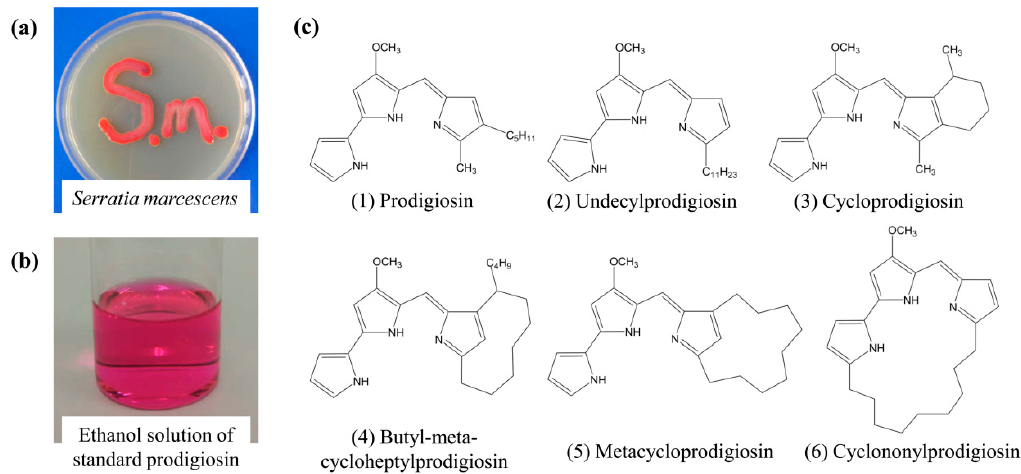
Figure 1. ( a ) Serratia marcescens ; ( b ) ethanol solution of standard prodigiosin; ( c ) chemical structures of the representative members of prodigiosins family.